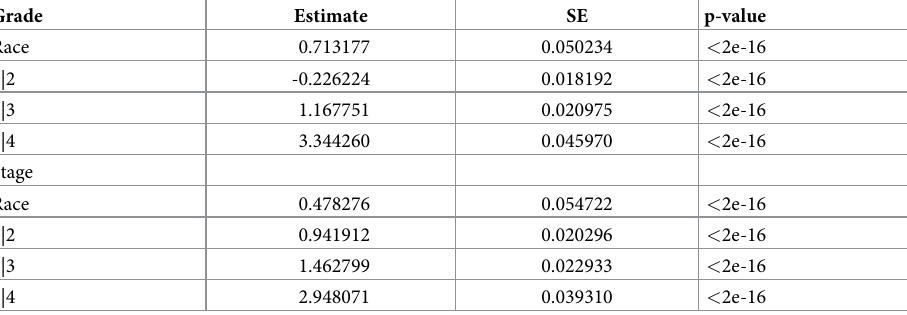
each level of categorical individual variables. Once again, the majority of p-values are highly significant. From Table 3, for Grade, for WNH versus BNH, the log odds of observing grade 1 versus grade 2 or higher grades is increased by 0.713. For Stage, for WNH versus BNH, the log odds of observing Stage 1 versus Stage 2 or higher is increased by 0.478. For Table 2, the coeffi- cients are interpreted as: for WNH versus BNH, the log odds of being in that category versus in the reference category is increased or decreased by the estimated coefficient where the refer- ence groups of Insurance, Surgery, Chemo, Marital Status and Histology are insured, NOS, Hysterectomy, Chemo, Divorced and Carcinosarcoma respectively. S1 Table of the S1 File gives the list of social determinants of health that were extracted from American Community Survey (ACS) data by linking geocoded census tracts from FCDS. Kaplan-Meier survival curves were plotted in S1 Fig (S1 File) for our analytic sample com- paring NHB and NHW. Of the 13,506 cases in our cohort, 11019 were censored (81.5%) for Table 3. Racial differences by grade and stage